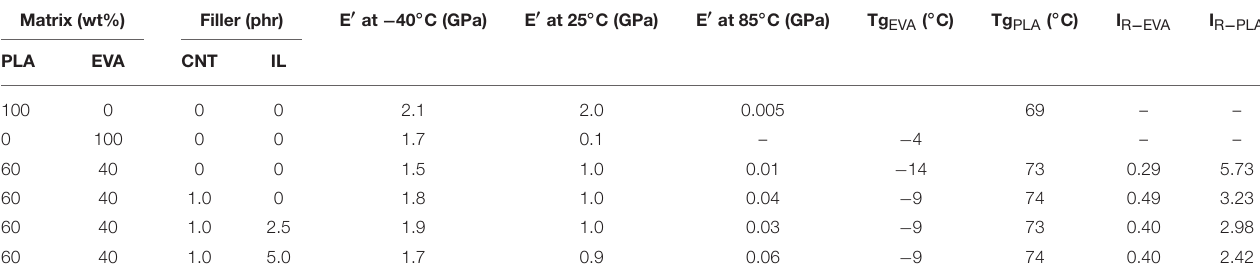
TABLE 3 | Dynamic mechanical properties of PLA, EVA, and PLA/EVA (60:40 wt%) composites. Matrix (wt%)